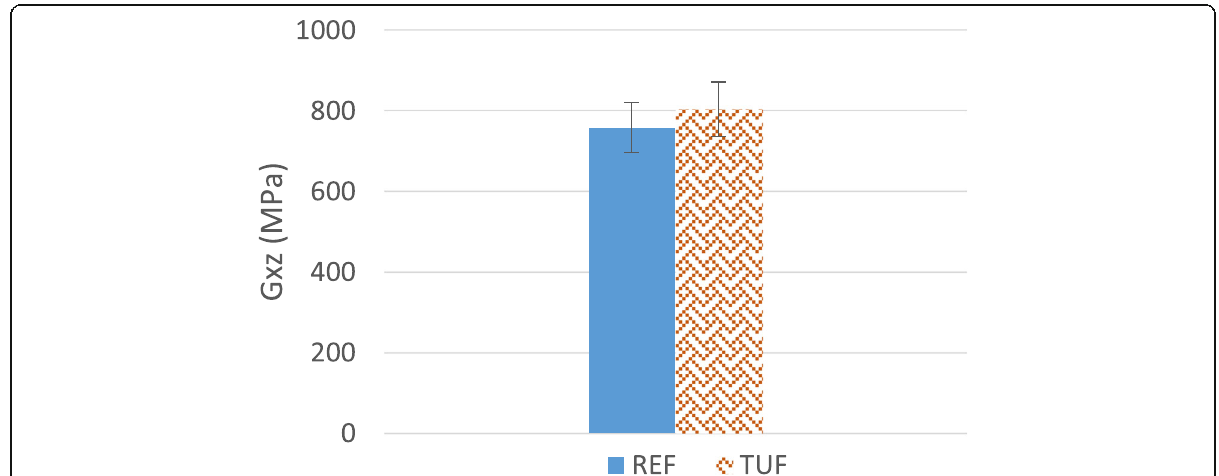
Fig. 11 Interlaminar shear modulus (Gxz) for REF and